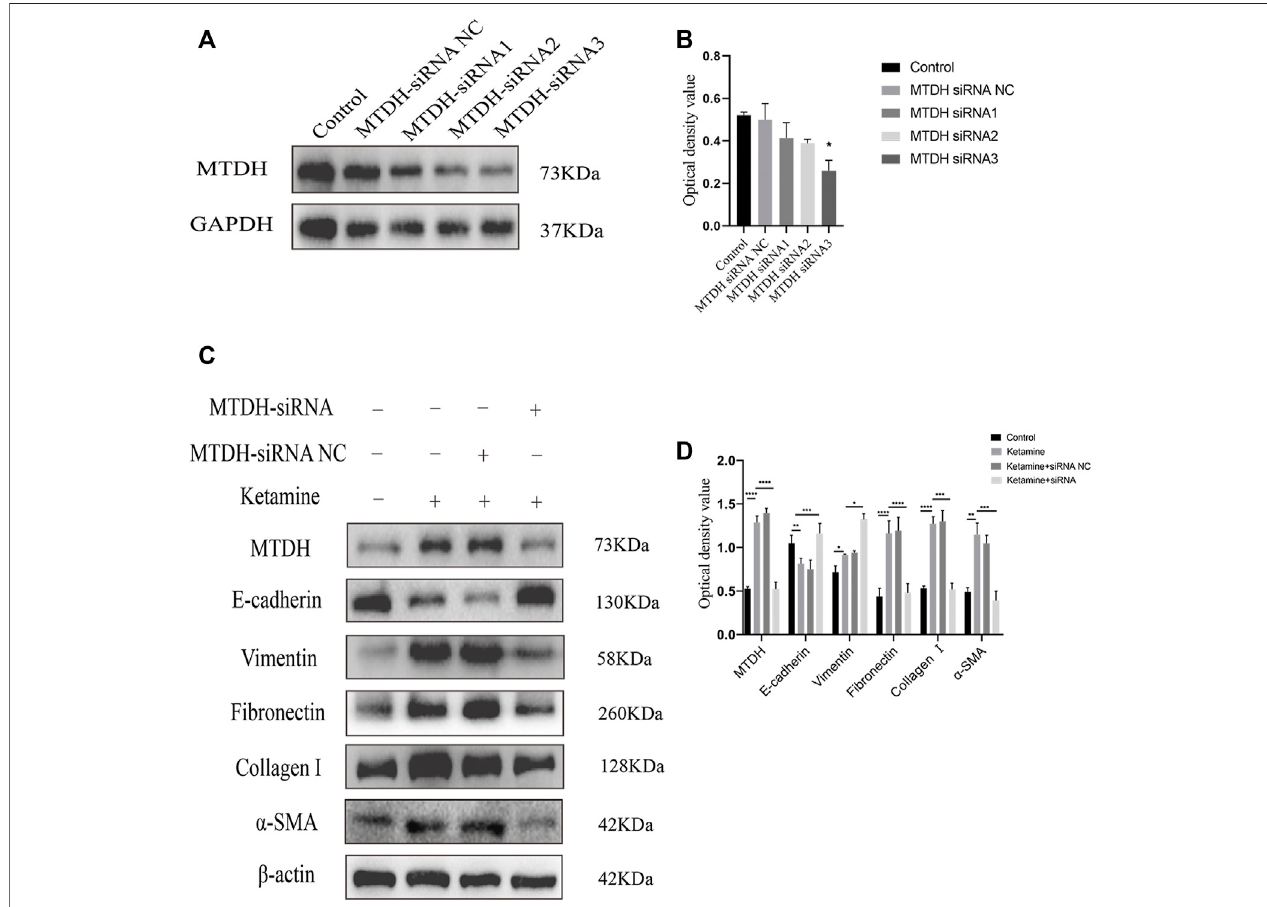
FIGURE 4 | Selection of MTDH siRNA and the expression of EMT and fi brosis marker proteins after silencing MTDH. (A) Representative bands from Western blot analyses of the levels of the MTDH in SV-HUC-1 cells after being transfected with MTDH siRNA negative control (NC), MTDH siRNA 1, MTDH siRNA 2, MTDH siRNA 3. (B) Relative levels oftheMTDH compared toGAPDH.* p < 0.05compared withcontrol. (C) Representativebands fromWesternblot analyses ofthe levelsoftheMTDH, E-cadherin, vimentin, fi bronectin, collagen Ⅰ , α -SMA protein in SV-HUC-1 cells after being treated with ketamine, ketamine and MTDH siRNA NC, ketamine and MTDHsiRNA3(treatedfor48 h). (D) RelativelevelsoftheMTDH,E-cadherin,vimentin, fi bronectin,collagen Ⅰ , α -SMAproteincomparedto β -actin.* p < 0.05;** p < 0.01; *** p < 0.0001; ; **** p < 0.0001. N (cid:1) 3.